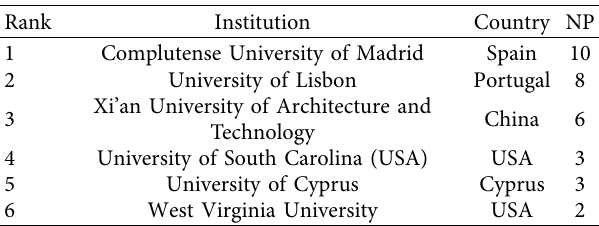
Table 2: Ranking of academic institutions by number of publi- cations